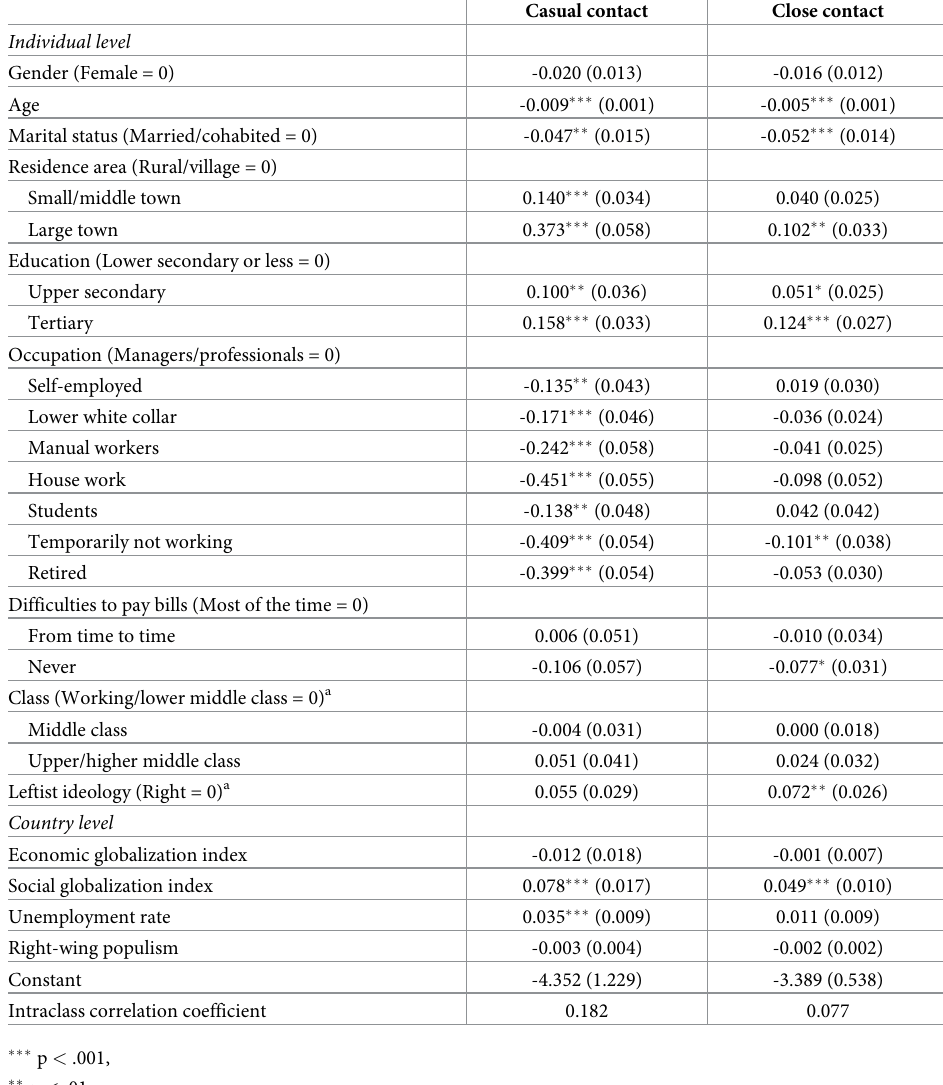
Table 3. Multilevel analysis of contacts (N =